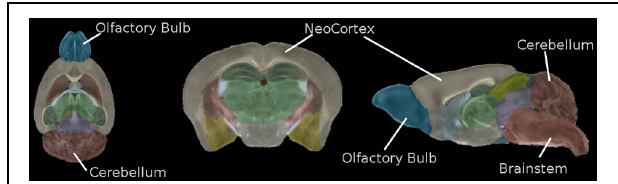
FIGURE 9 | Regional segmentation of the population average FA image. From left to right: Axial view, coronal view, sagittal view. The list of the different regions is: Hippocampus, Corpus Callosum and External capsule, Caudate and Putamen, Anterior commissure, Globus Pallidus, Internal capsule, Thalamus, Cerebellum, Superior Colliculi, Ventricle, Hypothalamus, Inferior colliculi, Central Gray, Neocortex, Amygdala, Olfactory Bulb, Brain Stem, Rest of Midbrain, Basal Fore Brain and Septum, Fimbria, Pituitary.